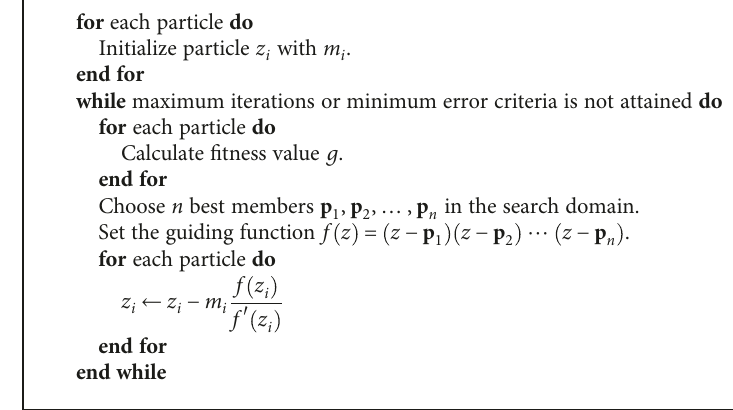
Algorithm 1: Newton Particle Optimization (in ℂ ).